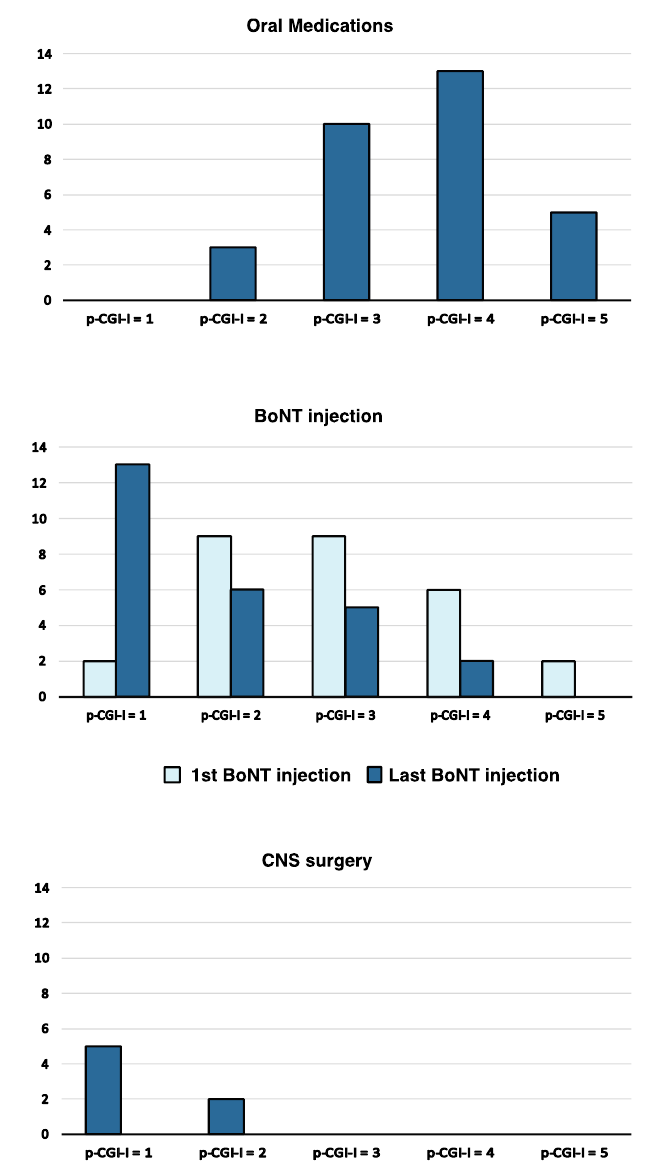
Figure 3. Patient-based Clinical Global Improvement (p-CGI-I) as per treatment for tremor . More patients reported improvement on the p-CGI-I with botulinum toxin (BoNT) injections and neurosurgery compared to oral medications. The percentage of p-CGI-I ≤ 3 was significantly higher when comparing the first and last injection of BoNT (74% vs. 92%, Fisher’s exact test p = 0.04). P-CGI = 1: Very much improved, 2: Much improved, 3: Minimally improved, 4: No change, 5: Minimally worse, 6: Much worse, 7: Very much worse.